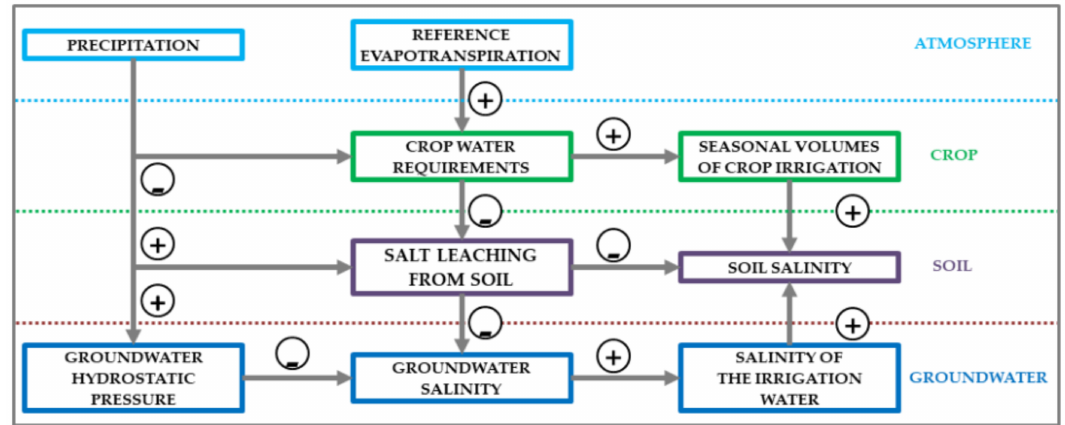
Figure 2. Cause–effect relationships among the factors related to weather, crop, soil, and groundwater, affecting soil salinity. Precipitation always favours a decrease in soil salinity by reducing the irrigation supply, promoting soil salt leaching, and avoiding the seawater intrusion into groundwater. The plus and minus signs identify positive and negative correlations, respectively. The final effect of one certain factor on soil salinity is obtained by multiplying the signs along the